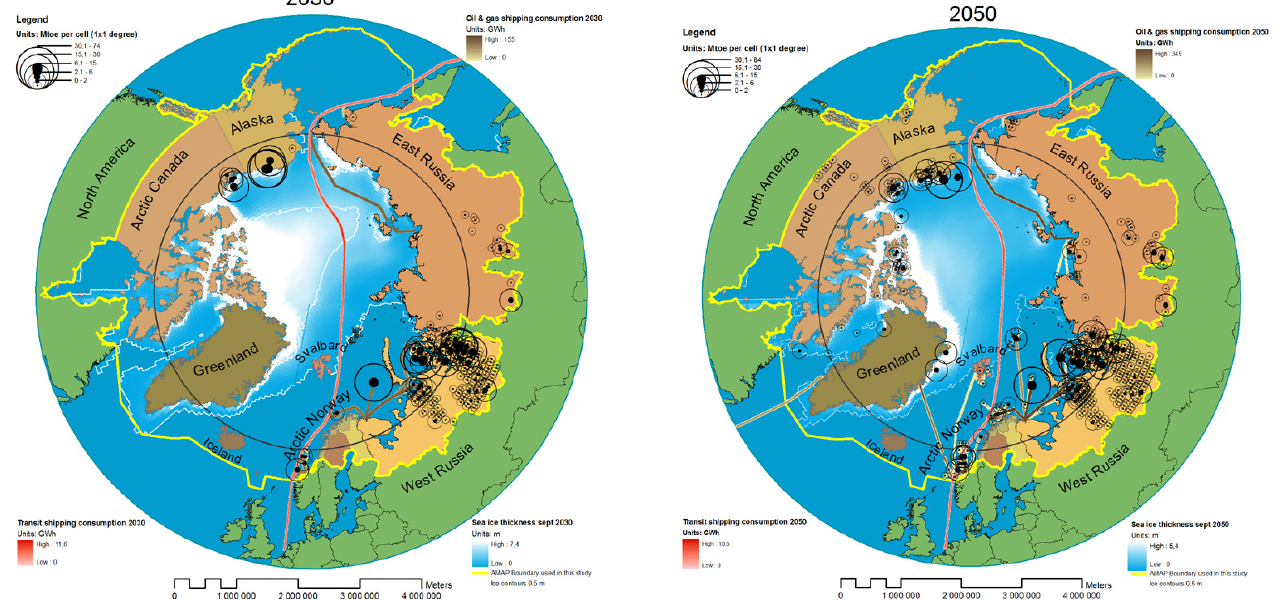
Fig. 4. The oil and gas extraction (measured in Mtoe), energy consumption in transit and petroleum shipping (measured in GWh), and the September sea-ice extent in (a) 2030 and (b) 2050. These data are combined with emission factors to produce the results in respective tables. The transit shipping only occurs during the summer months, while the oil and gas transport occurs throughout the